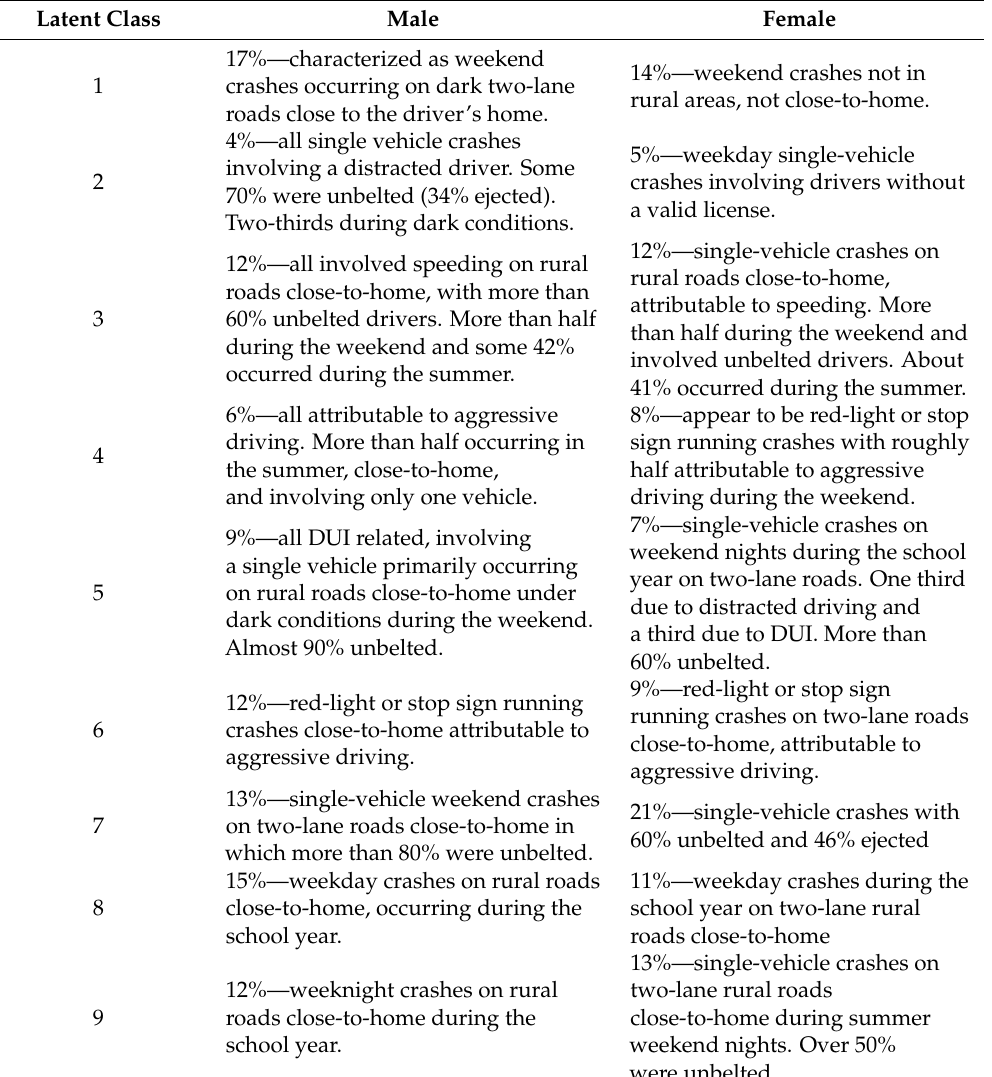
Table 6. Categorization of classes of crashes by